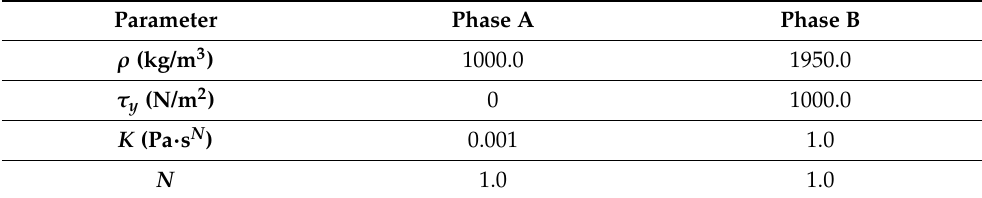
Figure 14. Geometrical configuration of a submarine debris flow. Modified from [58]. Table 2. Physical and rheological parameters used in submarine debris flow test.